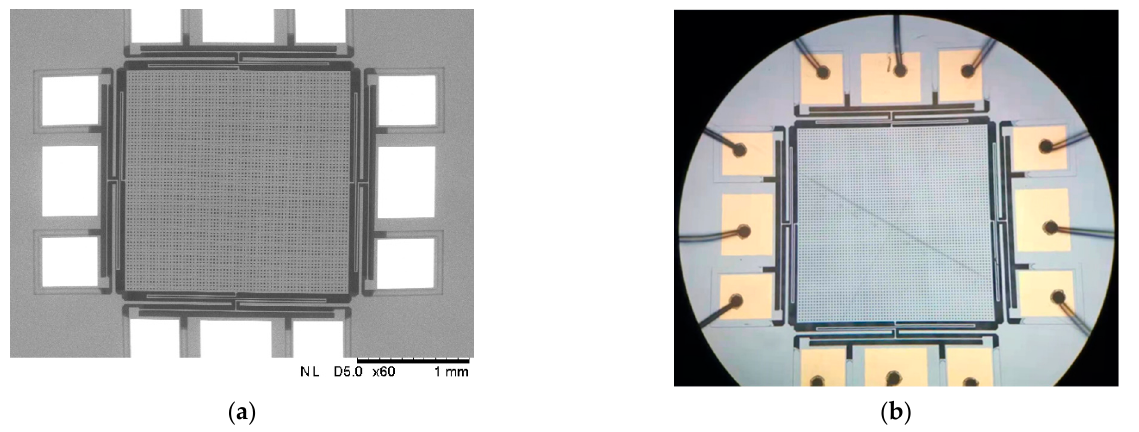
Figure 8. ( a ) The SEM image of the sensor; ( b ) t he picture of sensor chip under a microscope.